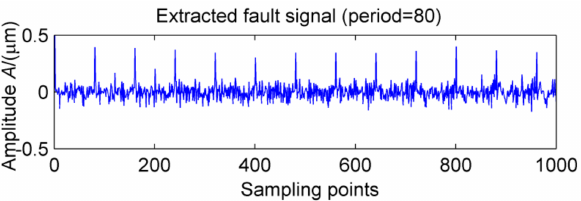
Figure 3. MOMEDA-filtered output impact signal at a period of T = 80.